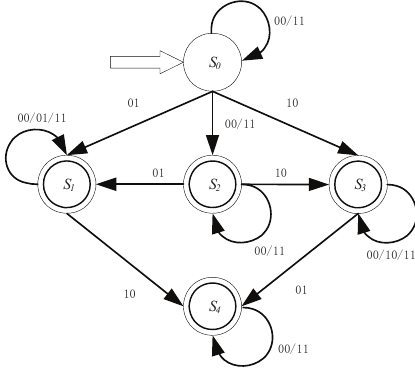
Figure 6. A Deterministic Finite Automaton for Column Relations.